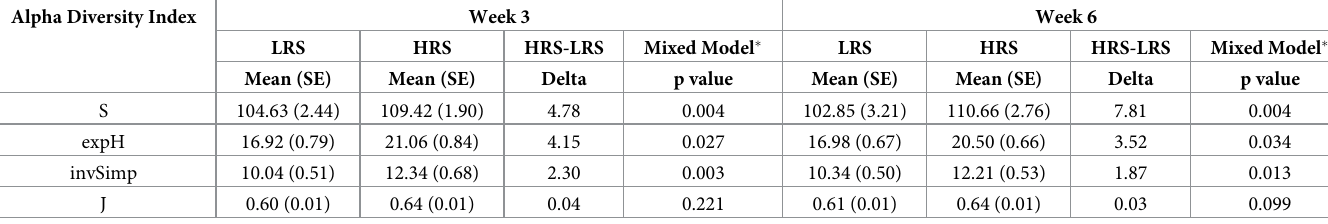
Table 9. Alpha diversity metrics from fecal samples from cats fed LRS or HRS